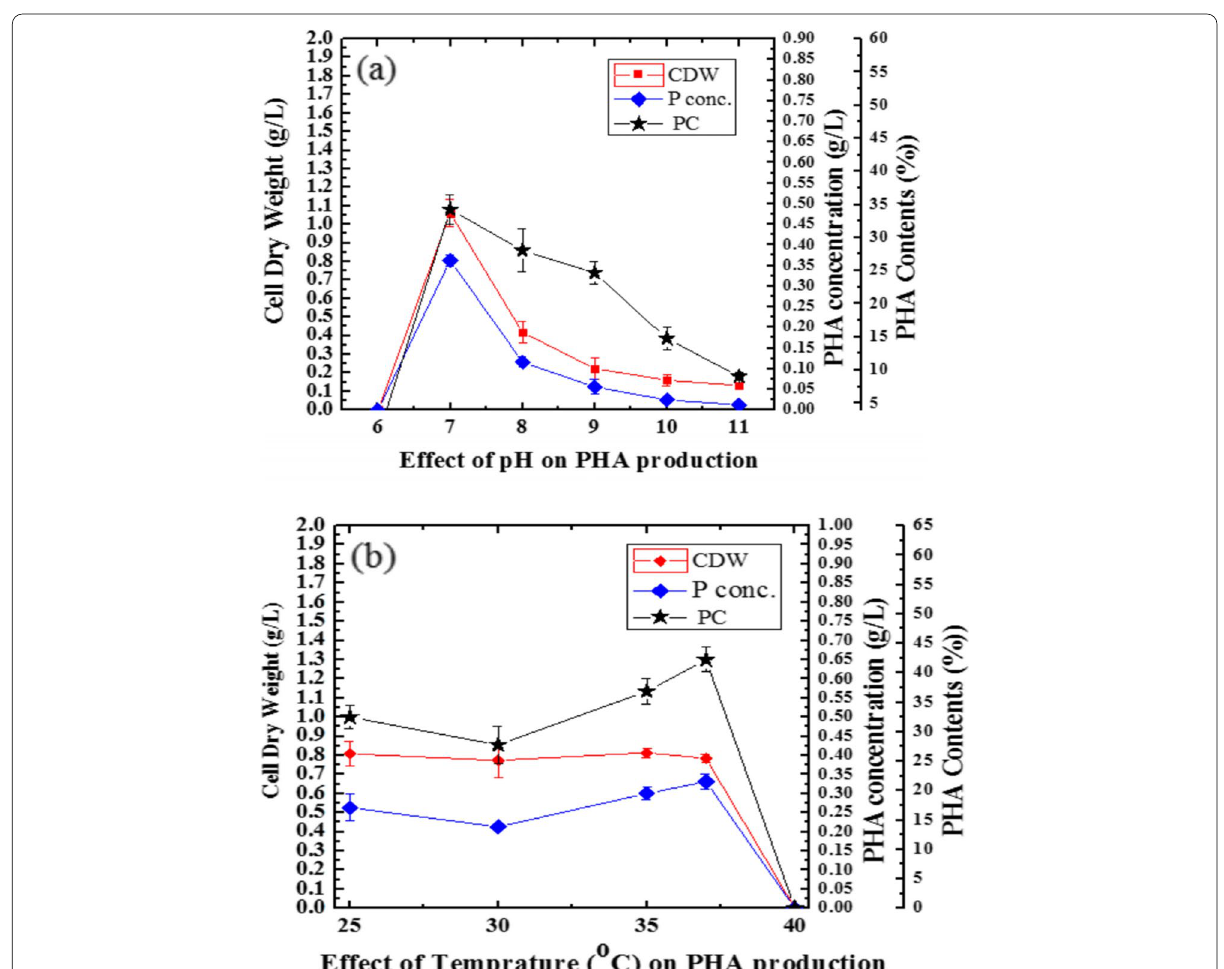
Fig. 5 a PHA contents (PCs) for Bacillus sp. LPPI-18 over a range of 7–11 pH value. b PHA production at a different temperature when 1% glucose was supplemented as a carbon source. Data represented the mean